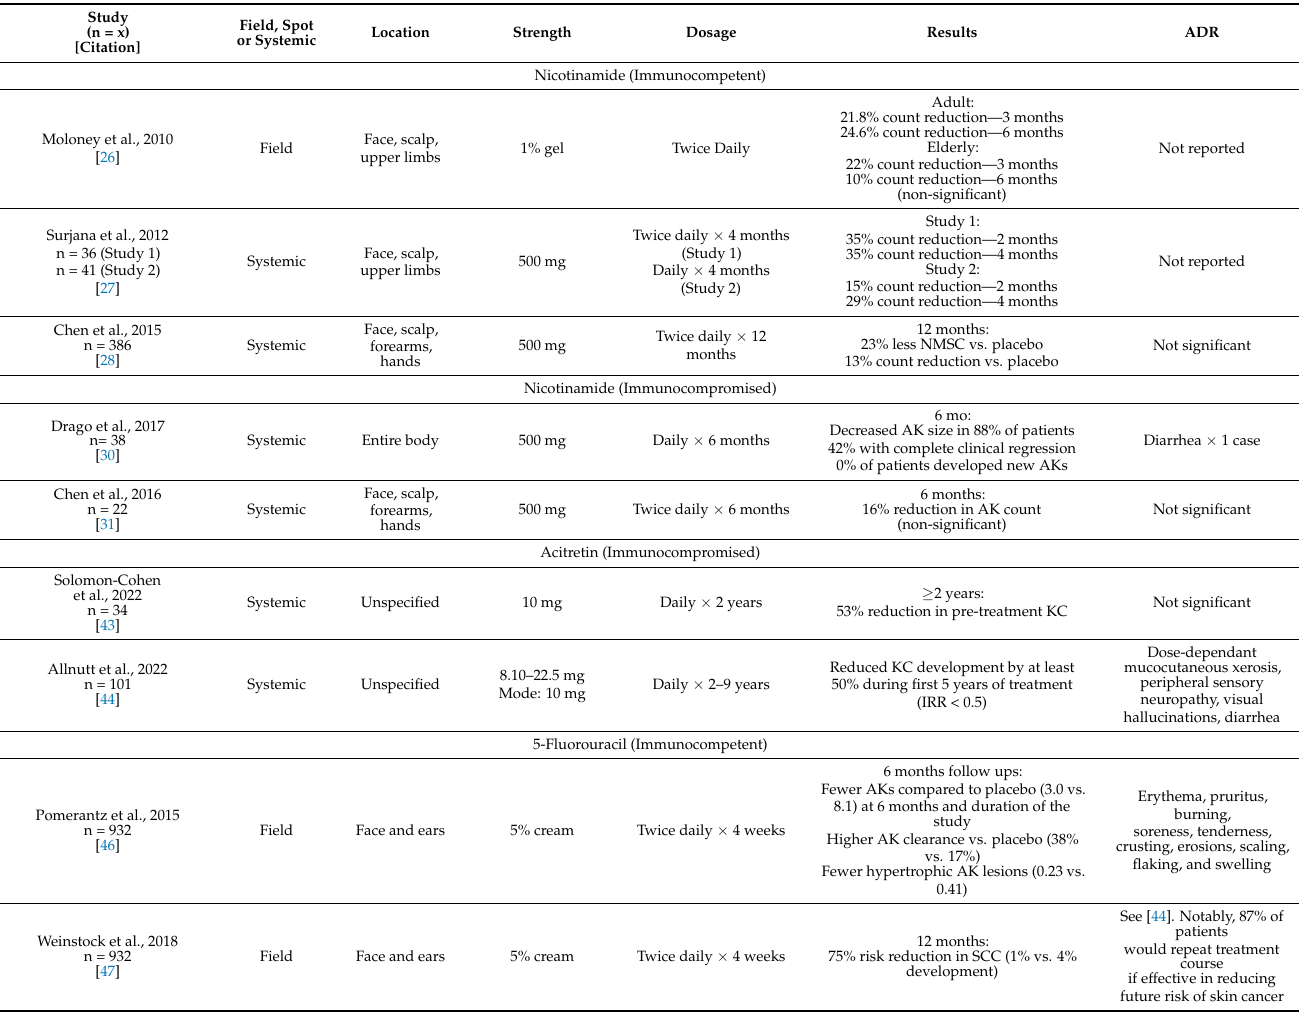
Table 1. Summary of randomized-controlled, case–control and cohort chemoprophylactic interven- tion studies conducted since